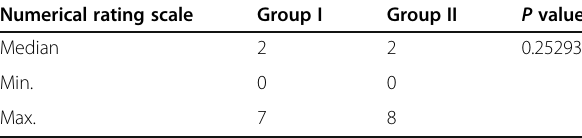
Table 4 The numerical rating scale for pain among the two